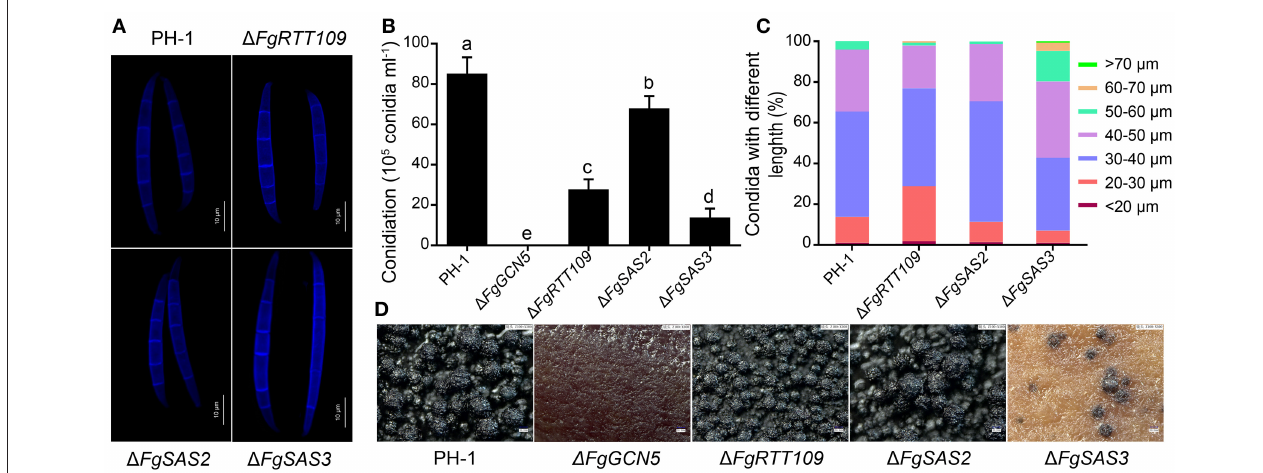
FIGURE 3 | Morphologies of conidia and the formation of perithecia. (A) Microscopic observations of conidial morphology of PH-1, 1 FgRTT109 , 1 FgSAS2 , and 1 FgSAS3 . Differential interference contrast (DIC) images of conidia stained with calcofluor white were captured with an electronic microscope. Scale bar = 10 µ m. (B) The number of conidia produced by PH-1, 1 FgRTT109 , 1 FgSAS2 and 1 FgSAS3 strains. Error bars indicate the standard deviations of three repeated experiments. Values on the bars followed by the same letter are not significantly different at P = 0.05. (C) Percentages of conidia with different lengths in PH-1, 1 FgRTT109 , 1 FgSAS2 and 1 FgSAS3 strains. (D) Microscopic observations of perithecia. Perithecia formation of PH-1, 1 FgGCN5 , 1 FgRTT109 , 1 FgSAS2, and 1 FgSAS3 were photographed by digital microscope VHX-2000 at 2 weeks post-fertilization after sexual induction on carrot agar. Mutant 1 FgGCN5 failed to produce